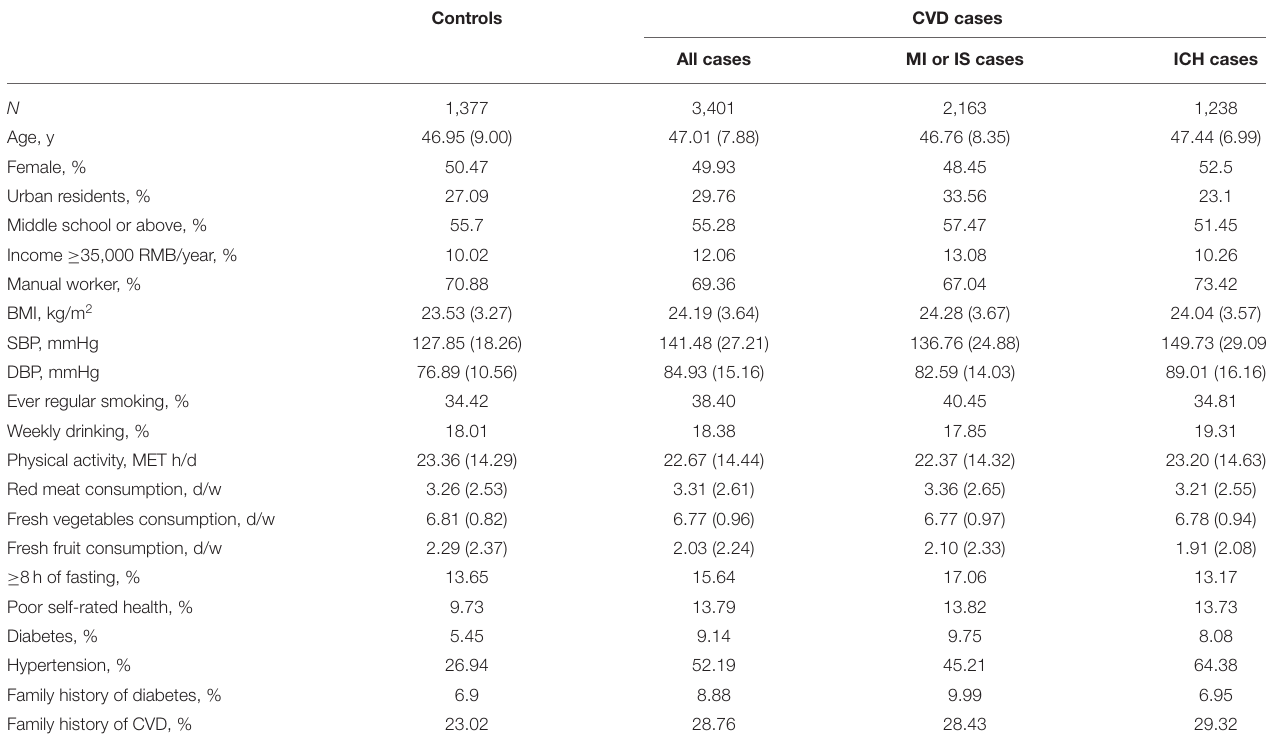
TABLE 1 | Baseline characteristics among 4,778